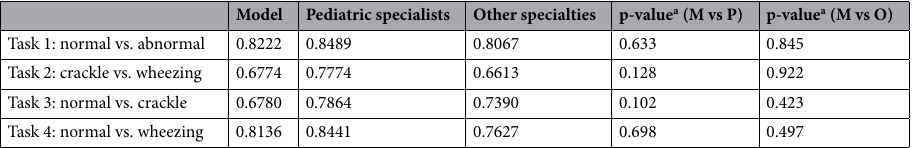
Table 4. Comparison of the accuracies of the model and 10 physicians for the prospective validation set. M model, P pediatric specialists, O physicians with other specialties. a Chi-square